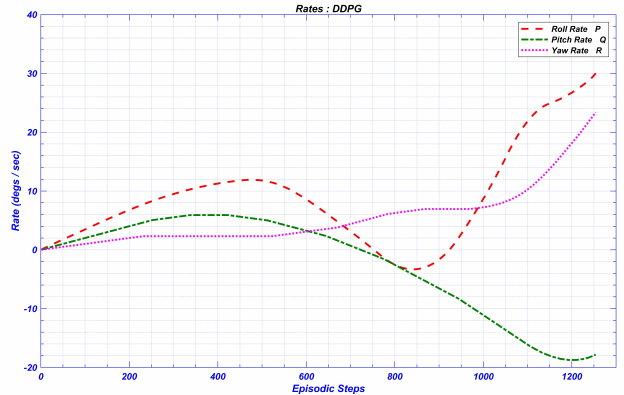
Figure 2. Angular rates variation.